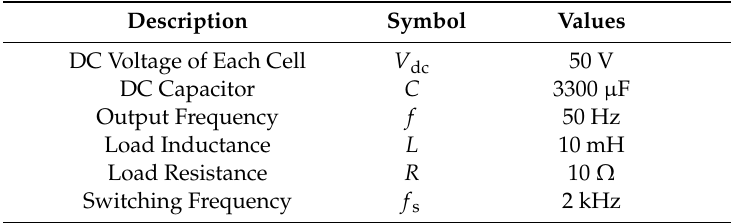
Figure 10. Overview of the experimental five-level CHB setup. Table 4. Experimental